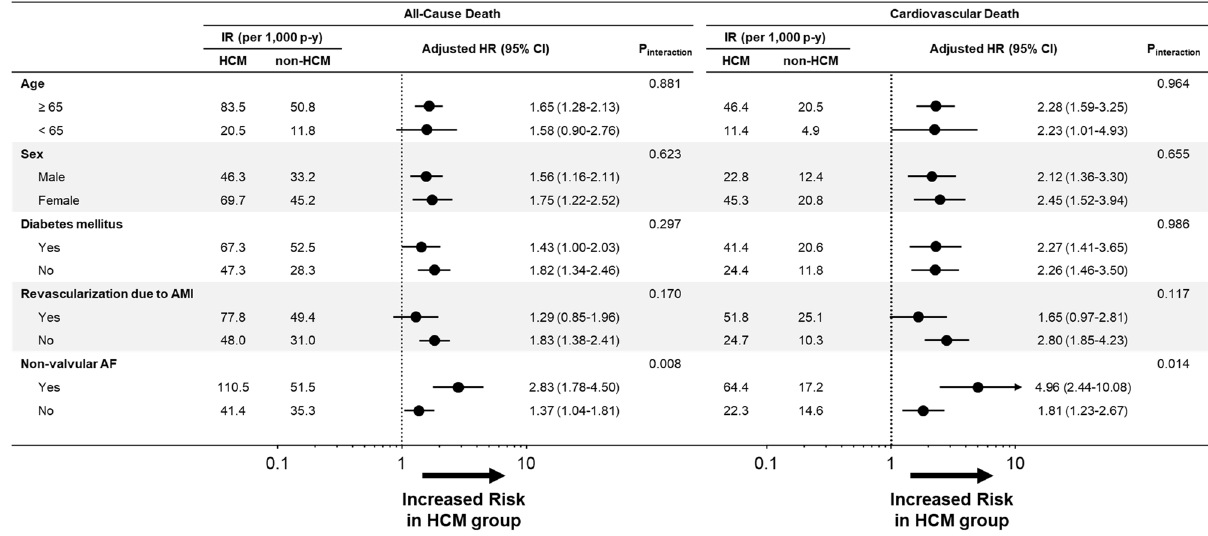
Figure 4. Subgroup analysis for all-cause death and cardiovascular death. Subgroup analyses across various exploratory subgroups for all-cause death and cardiovascular death are shown. Abbreviations: AMI, acute myocardial infarction; CI, confidence interval; HCM, hypertrophic cardiomyopathy; HR, hazard ratio; IR, incidence rate; p-y,